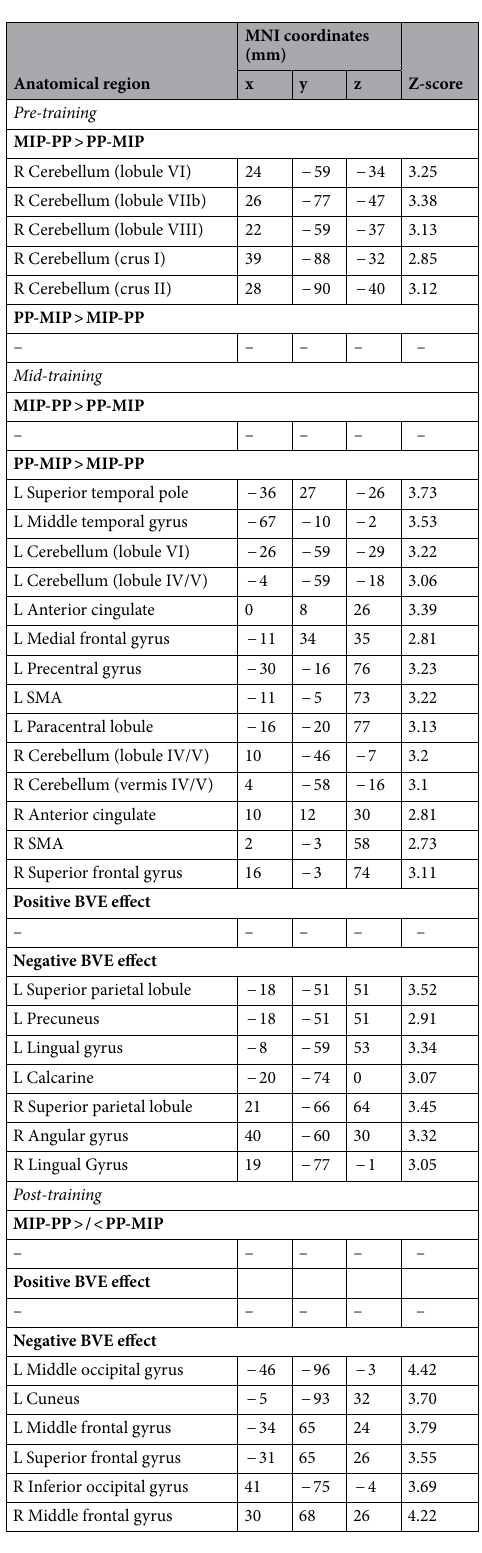
Table 4. MNI coordinates of local maxima resulting from between-group comparisons conducted at each time point (only coordinates from peak voxel are shown). Instances in which no significant differences in activation were noted are indicated by dashed